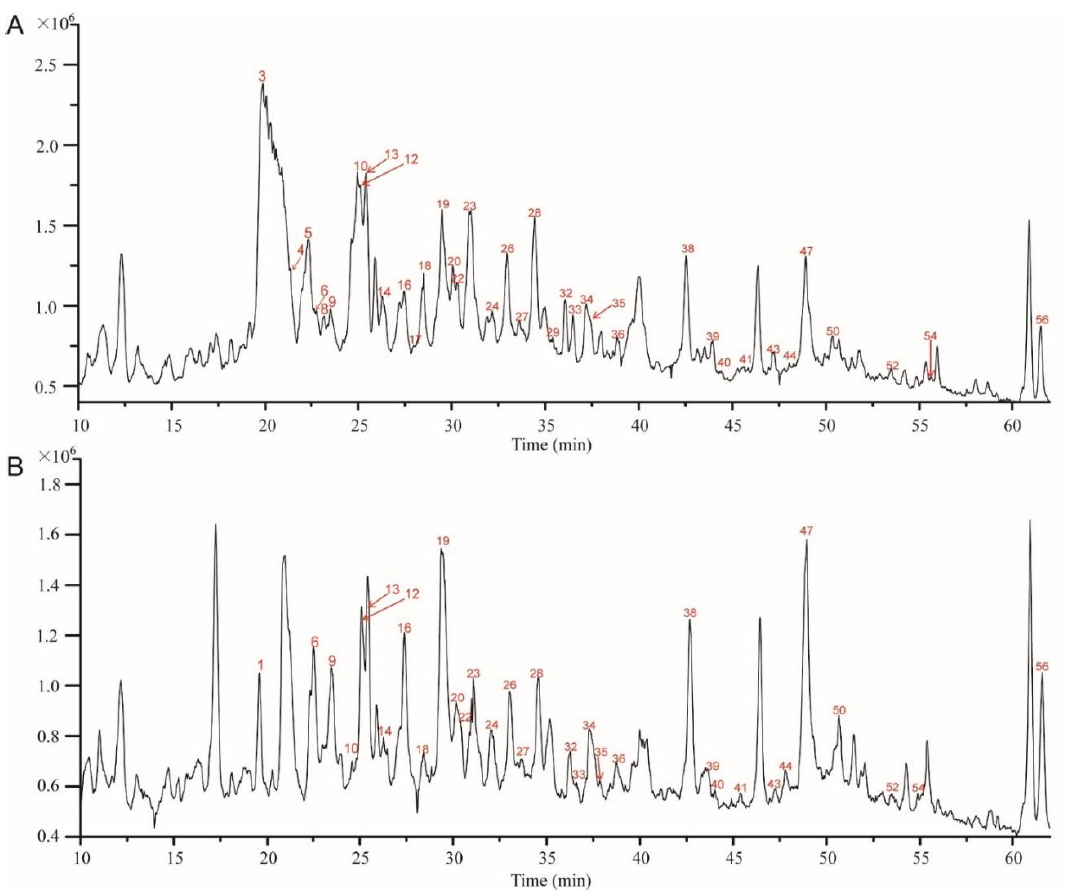
Figure 2. Liquid chromatography-electrospray ionization mass spectrometry (LC-ESI-MS) profile of phenolics from 5 WAF of yellow and black rapeseed. ( A ) black seed; ( B ) yellow seed. Peaks: (1) qn-3-